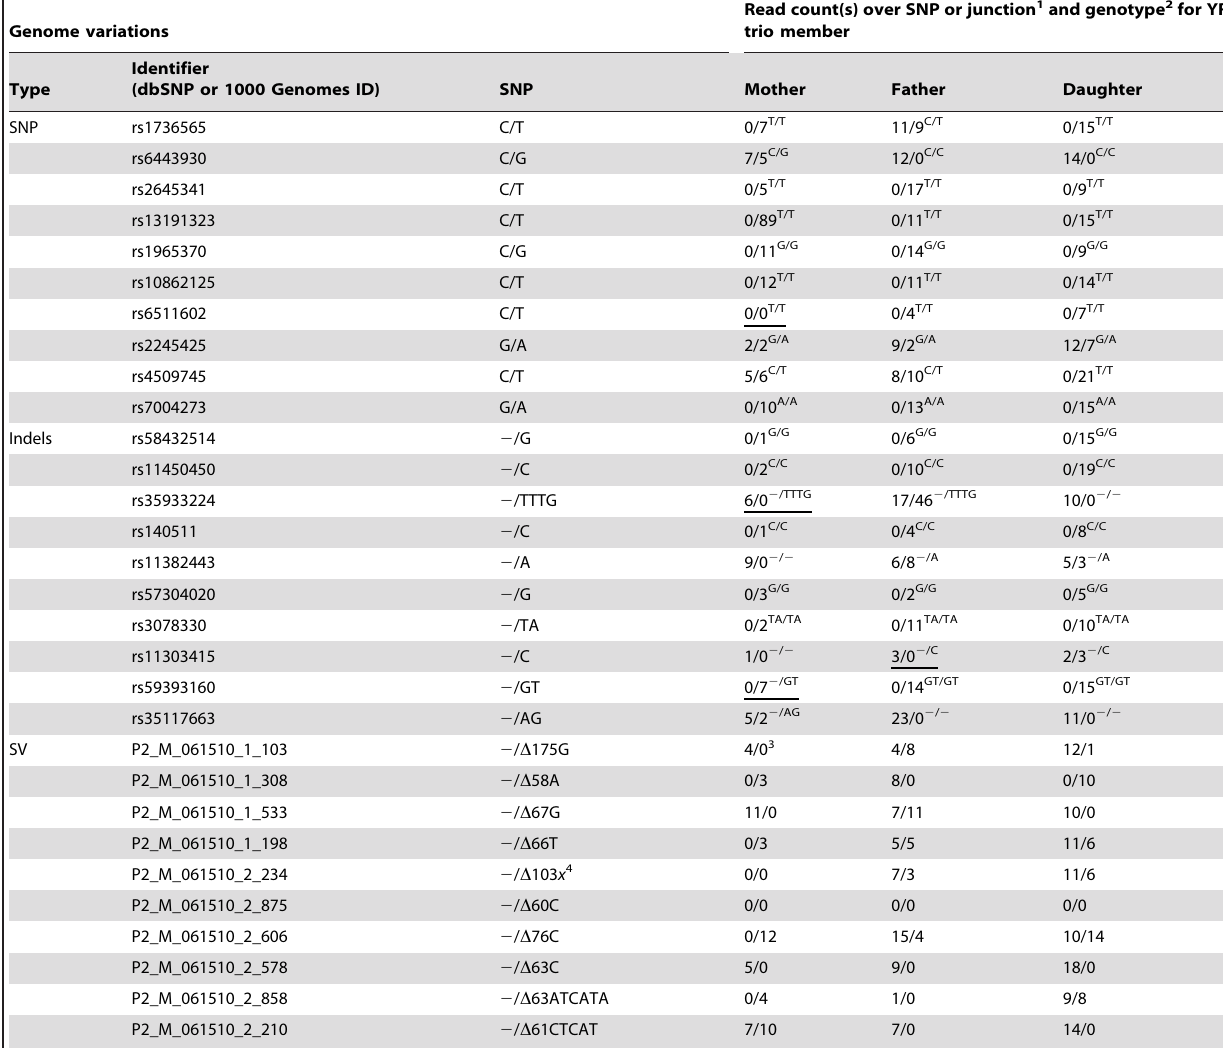
Read count(s) over SNP or junction 1 and genotype 2 for YRI trio